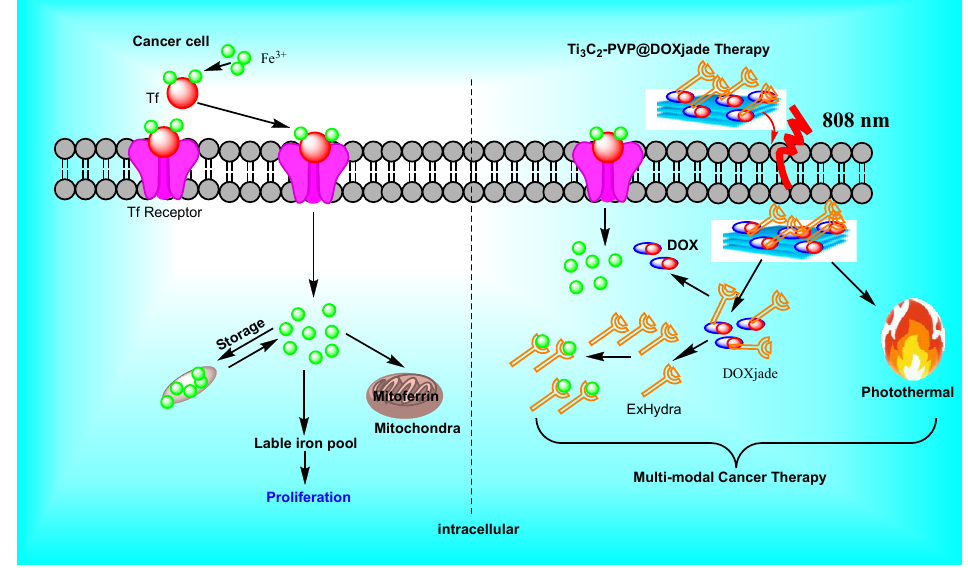
Figure 4. A plausible mechanism of 2D-ultrathin MXene/DOXjade platform for cancer therapy [95].